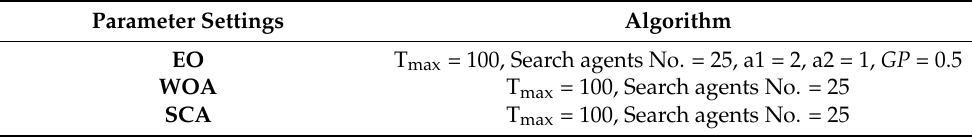
Table 3. The selected parameters of the optimization